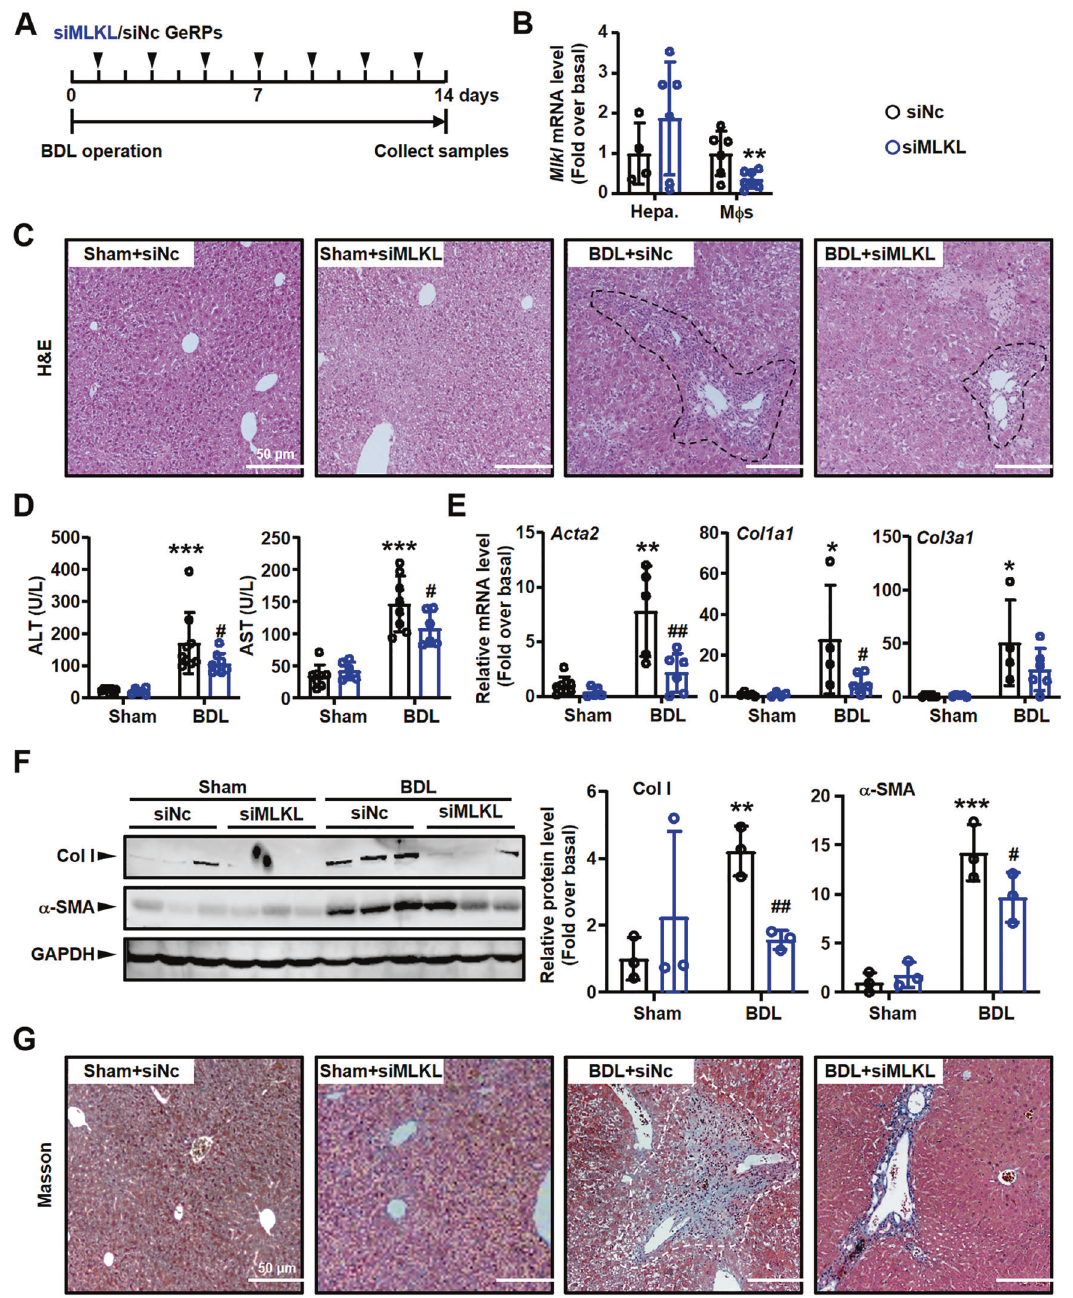
C Representative images of H&E staining. Black dashed: in fl ammation area. Scale bars: 50 μ m. D Serum AST and ALT levels were detected in NC or Mlkl siRNA-GeRPs pretreated BDL livers. E mRNA expressions of fi brosis markers ( Acta2 , Col1a1 and Col3a1 ) were detected by qRT-PCR. F Western blot analysis for Col I and α -SMA in the liver tissues from BDL mouse livers treated with NC or Mlkl siRNA-GeRPs. G Representative images of Masson staining. White dashed: collagen deposition area. Scale bars: 50 μ m. Data are presented as the mean ± SEM. * p < 0.05, ** p < 0.01, *** p < 0.001 (versus control). # p < 0.05, ## p < 0.01 (versus BDL